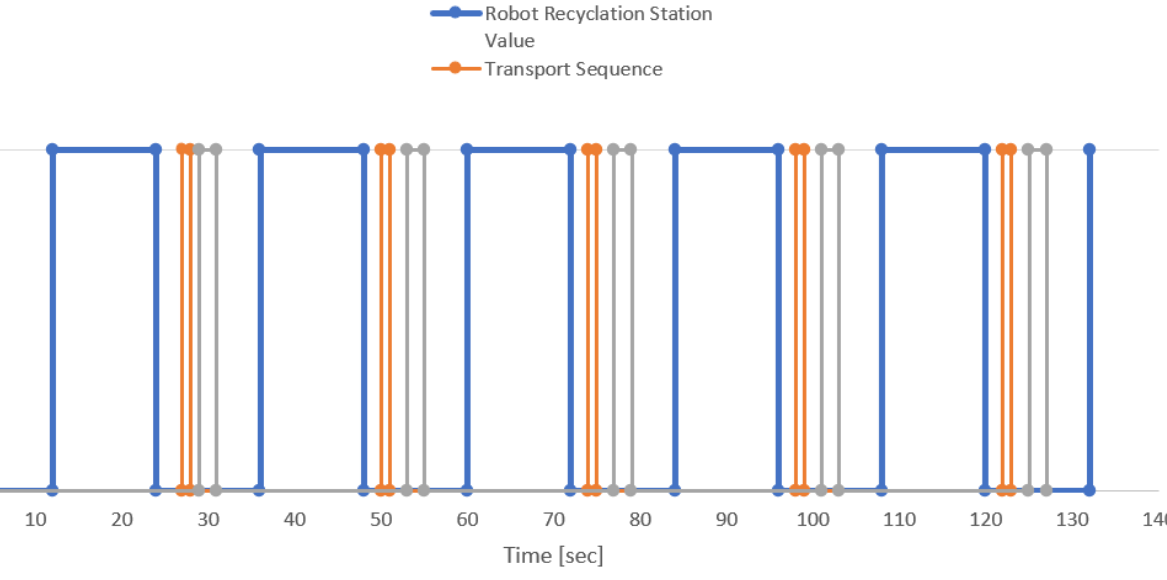
Table 3. Inputs, outputs, and a description of a basic function of the IIoT device.